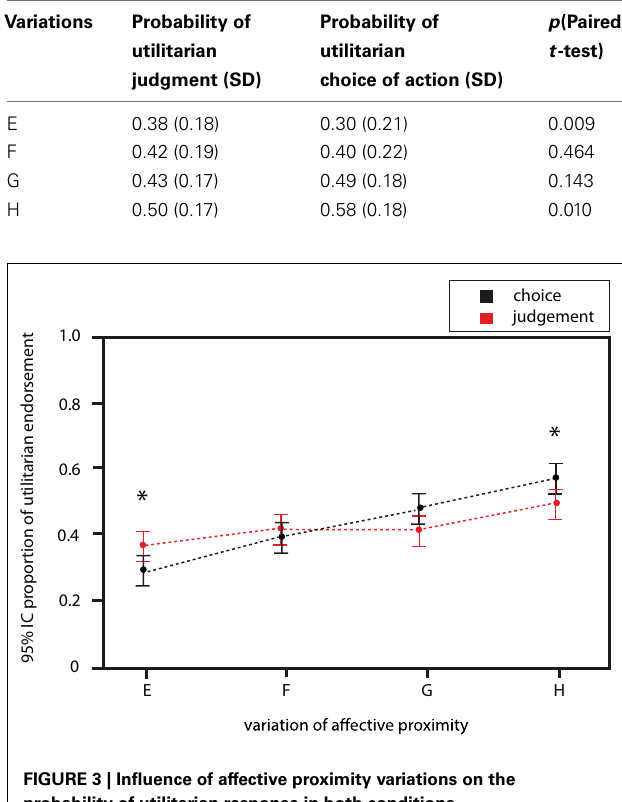
Table 1 | Probability of utilitarian judgment when varying the number of people benefiting from the decision.